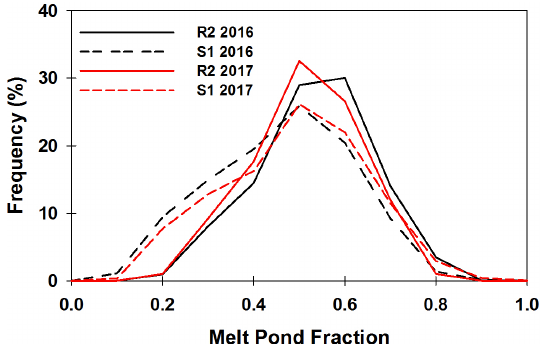
Figure 6. Frequency distribution (%) of RADARSAT-2 peak melt pond fraction ( f pk ) and Sentinel-1 f pk from Scharien et al. (2017) in the Canadian Arctic Archipelago for 2016 and 2017.